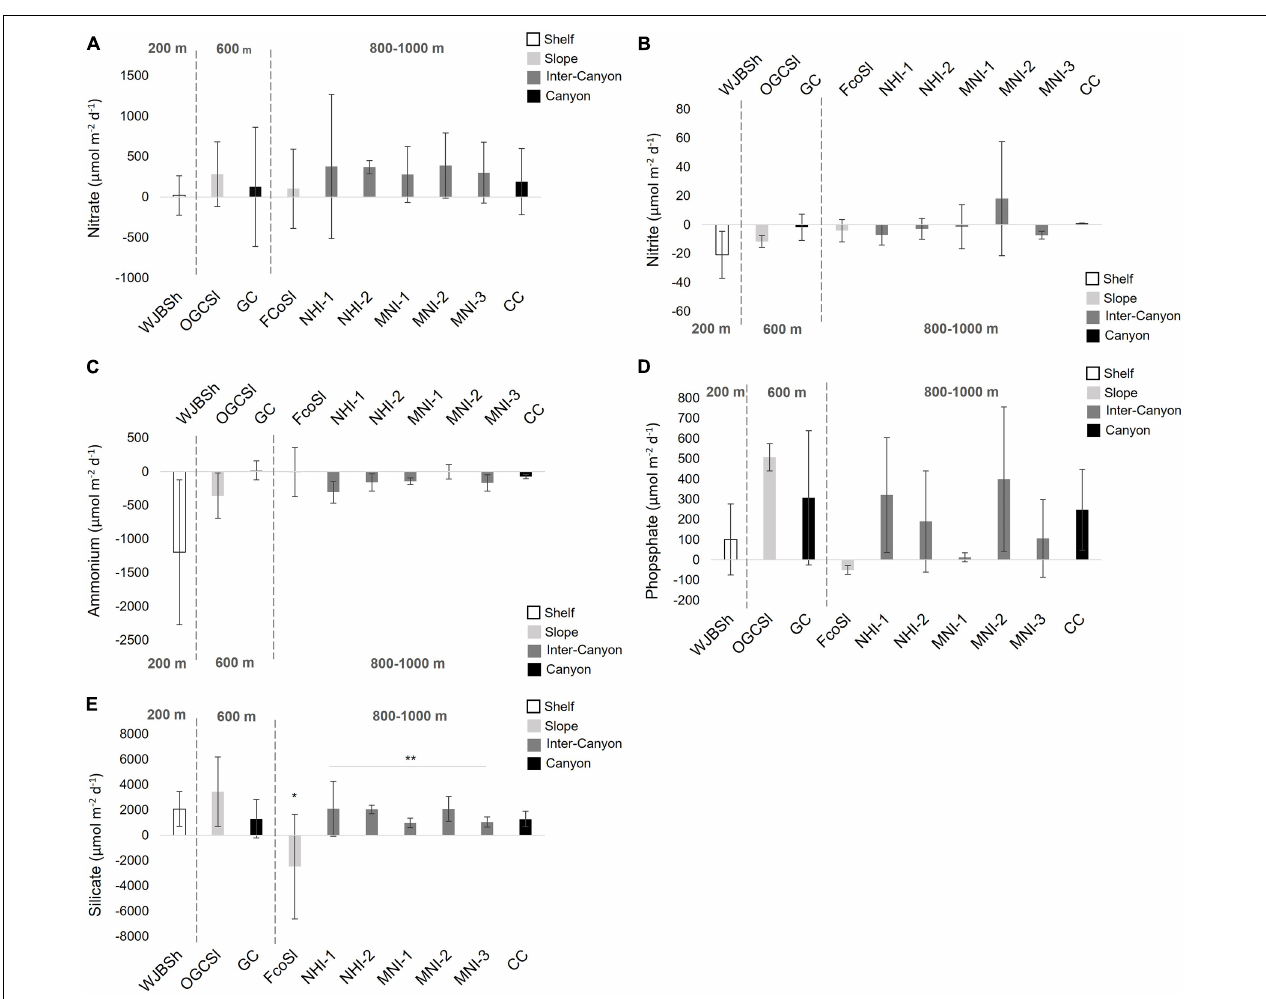
FIGURE 2 | Inorganic nutrient fluxes at the sediment-water interface in the 10 stations (average and standard deviation), expressed as µ mol m − 2 d − 1 . (A) Nitrate flux, (B) Nitrite flux, (C) Ammonium flux, (D) Phosphate flux, (E) Silicate flux. Positive values indicate release of nutrients from the sediment into the water column (efflux), whereas negative values indicate uptake by the sediment (influx). Vertical dash lines indicate the three depth classes used in the analysis (200, 600, and 800–1000 m). Symbols (*, **) highlight significant differences among habitats within each depth class (ANOVA, p < 0.05 or p < 0.01, respectively).